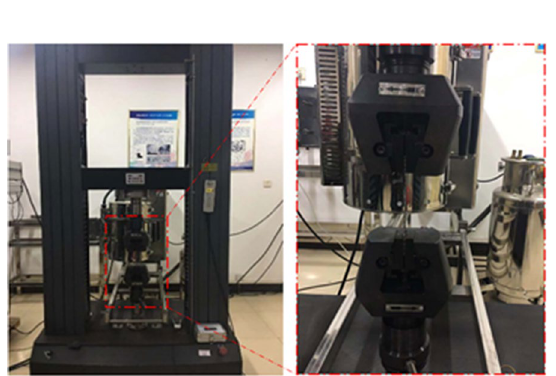
Figure 7 Stretching equipment and experiment